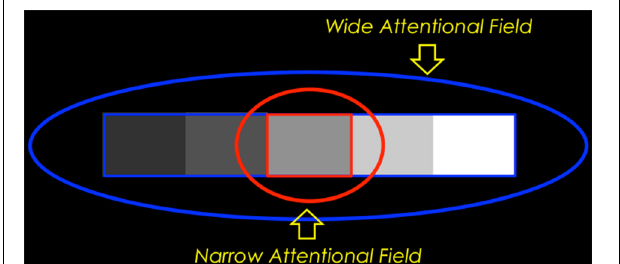
FIGURE 10 | Narrow-field vs. wide-field attentional processing of the paper lightnesses in the staircase-Gelb experiment. The observer suppresses through top-down feedback to V1 the responses of simple cells lying outside his field of spatial attention. When the observer examines the Gelb papers as a gestalt (attentional spotlight = blue oval), border ownership circuits in his cortical area V2 identify the border surrounding all five Gelb papers (blue rectangle); lightness is computed by comparing the luminance of each paper to the luminance of the common background field. When the observer focuses his attention on an individual paper (red oval), his border ownership circuits identify the border of that paper only (red rectangle); the paper lightness is computed by averaging the log luminance ratios of the four borders of the